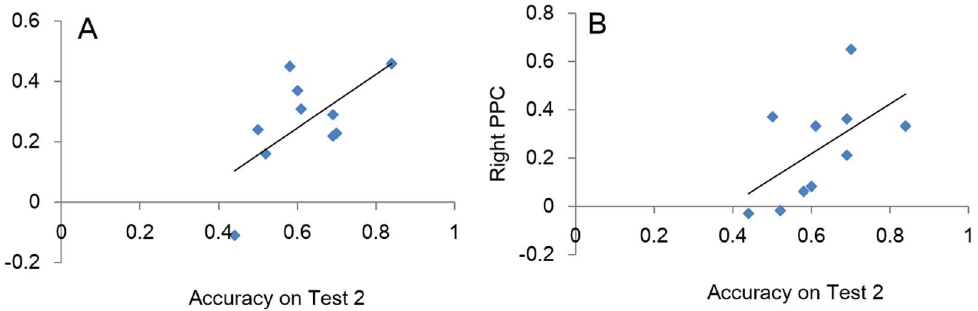
Figure 3. Correlations between accuracy on Test 2 and parameter estimates (beta values) of right PFC (A) and right PPC (B) during correct Test 1 trials (baseline corrected by incorrect Test 1